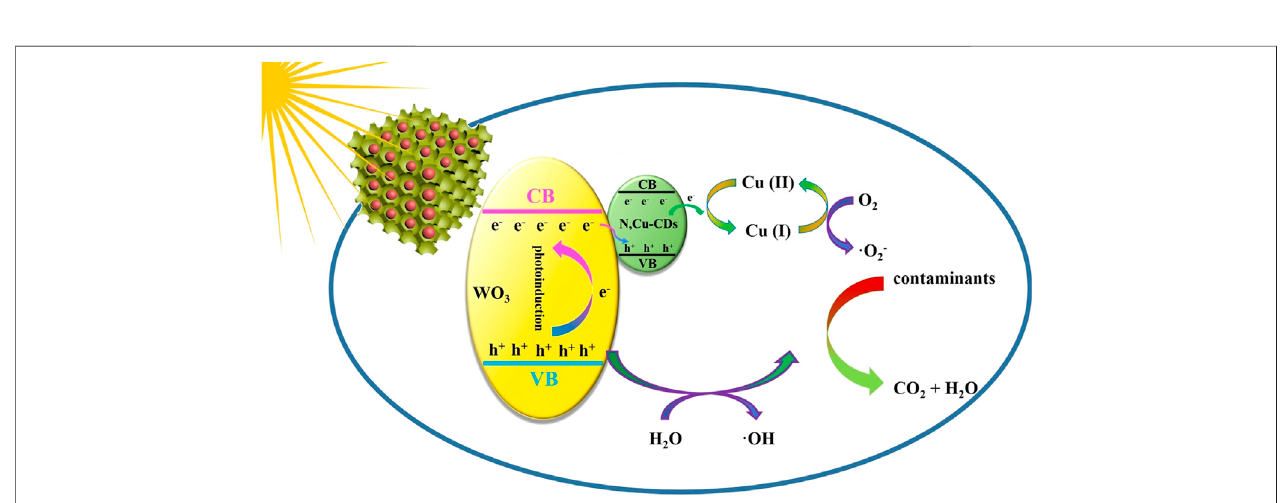
FIGURE 9 | Photocatalytic mechanism of the N,Cu-CDs/m-WO 3 -0.8 nanocomposite.